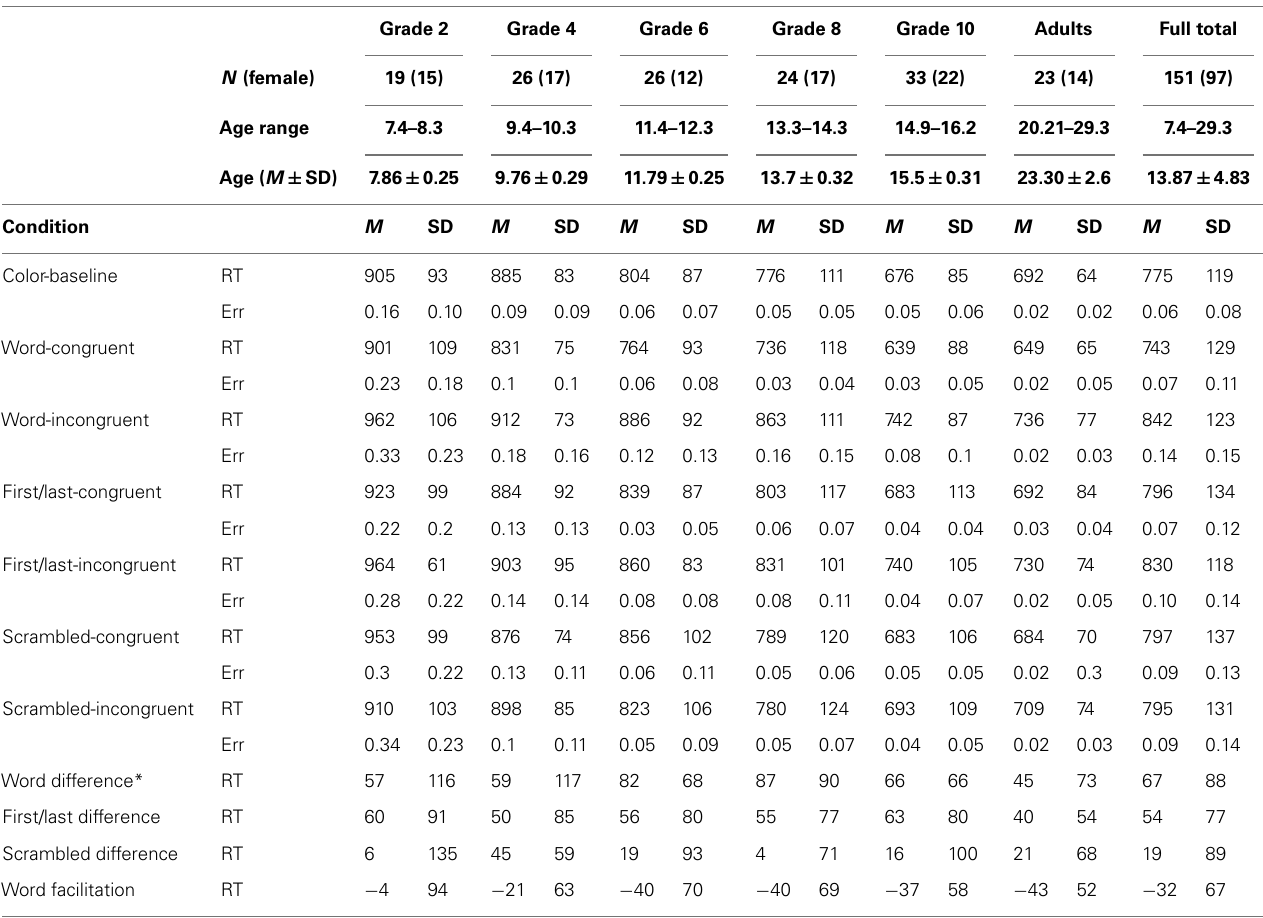
Table 1 | Participant characteristics and